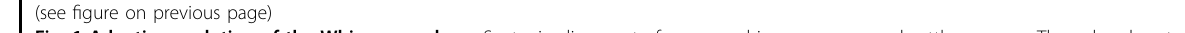
Fig. 1 Adaptive evolution of the Whippomorpha. a Syntenic alignment of common hippo genome and cattle genome. The colored syntenic linked lines present the major chromosome fusion events in the common hippo. The densities of coding genes and repeat sequences are calculated with a window size of 5 Mb. I: gene density; II: repeat density; III: CHR-1 density; IV: CHR-2 density; V: CHR-L density; VI: GC content. b General overview of genetic innovations in each clade of the Whippomorpha. c GO enrichment for the genes nearest to the diverged CNEs of Whippomorpha. d The similarity of sequence alignments for the EGF-CNE. H3K4me1 data of human epithelial cells was presented. e The mouse phenotype enrichments of cetacean-CNEs. f The putative cetacean-CNE concerning the HAND2 gene. The H3K4me3, H3K27Ac, and CTCF-binding atlas of human cardiac muscle primary cell lines. g The sequence alignments for the two divergent CNEs adjacent to HAND2 . h The gene tree shows the evolution of FGFR2 . i The FGFR2 protein sequence alignments. j Hi-C map for the common hippo on chr2 from 107.2 Mb to 109.2 Mb with 20 Kb resolution, and the CNE_W156 sequence alignments show that the 49-bp insertion was conserved in